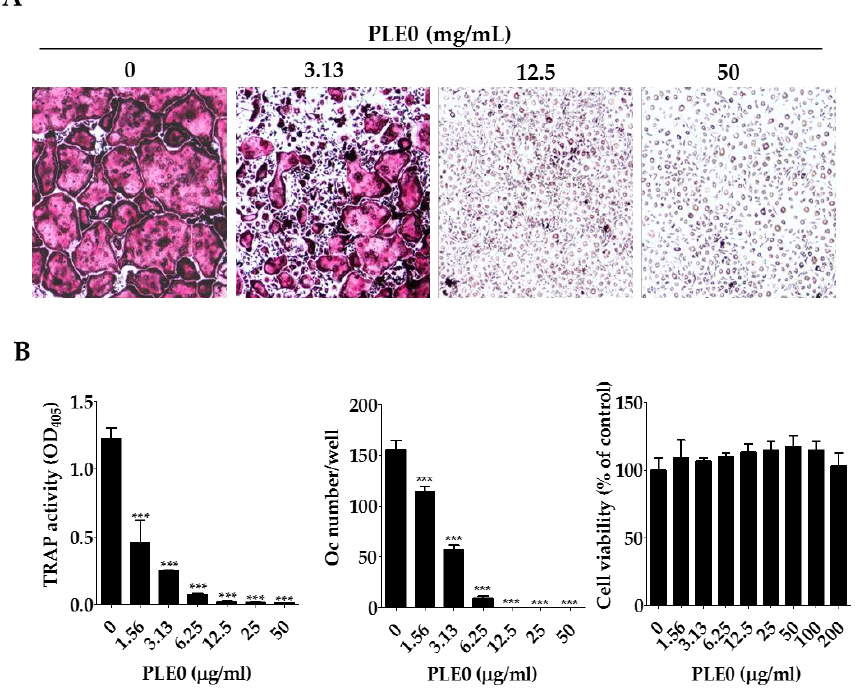
Figure 3. Effects of PLE0 on osteoclast differentiation in vitro. ( A, B ) BMMs were cultured with vehicle (distilled water) or PLE0 (1.56 – 50 μg/mL) in the presence of M -CSF (60 ng/mL) and RANKL (100 ng/mL) for four days. ( A ) Osteoclast differentiation from BMMs in the presence or absence of PLE0 (magnification, ×100). ( B ) TRAP activity, number of cells, and viability of osteoclasts (Oc) after PLE0 treatment (0–200 µ g/mL). After fixation and TRAP staining, TRAP-positive multinucleated giant cells ( ≥ three nuclei) were counted as osteoclasts. All data are represented as mean ± SEM and were analyzed with a one-way analysis of variance (ANOVA) and Dunnett’s post hoc test. ***, p < 0.001 versus no PLE0 treatment.